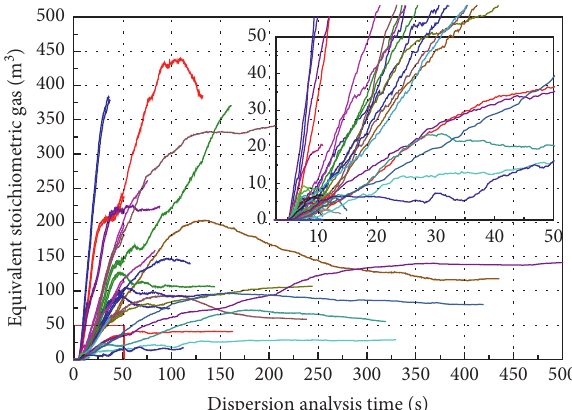
Figure 22: Equivalent stoichiometric gas volumes for 50 leak